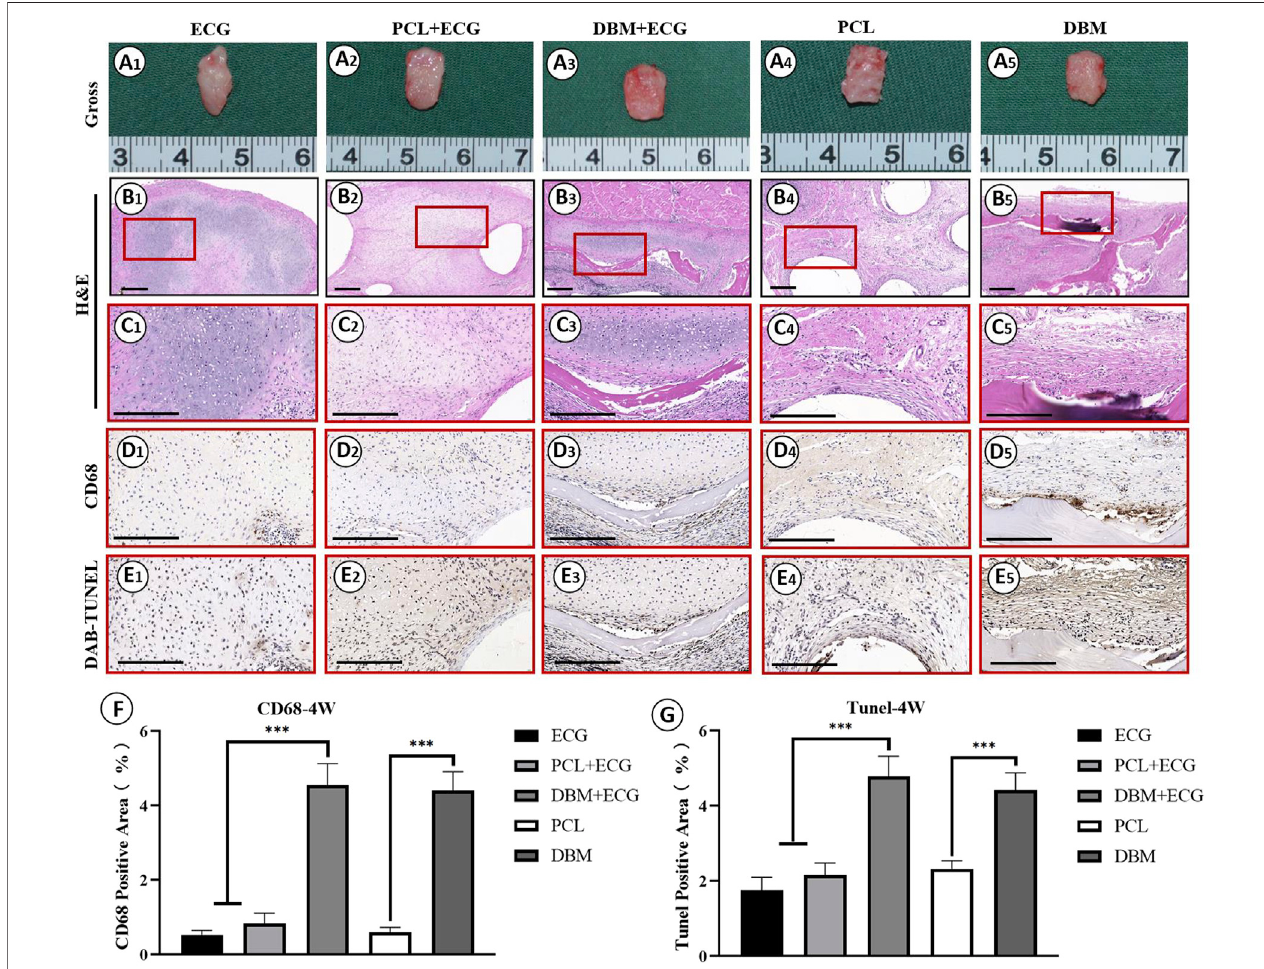
FIGURE 5 | In fl ammatory response evaluations of ECG, frameworks, and framework-ECG constructions after 4 week of subcutaneous implantation: Gross observation (A1 – A5) ; H&E staining with different magni fi cation ( B1 – B5, C1 – C5) ; CD68 immunohistochemical staining (D1 – D5) ; DAB-TUNEL immunohistochemical staining (E1 – E5) ; Semi-quantitative analysis of the CD68 (F) and DAB-TUNEL (G) positive area (%). Statistical signi fi cance: p p < 0.05, pp p < 0.01, ppp p < 0.001. Scale bar: 200 μ